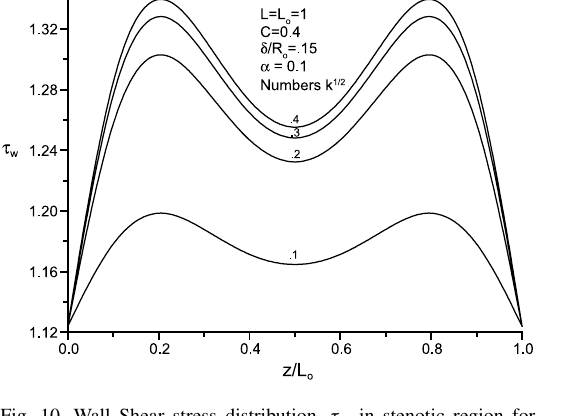
Fig. 10. Wall Shear stress distribution, τ w in stenotic region for different k 1 / 2 .